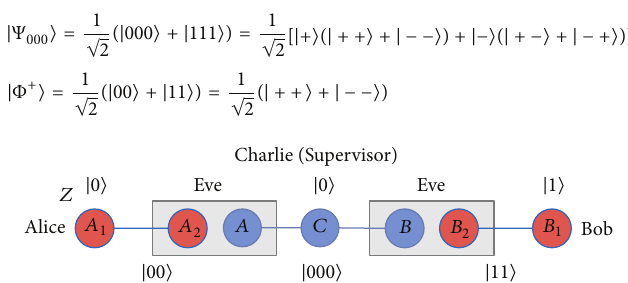
Figure 8: The scenario of external attack in which the legitimate users and controller measure the qubits 𝐴 1 , 𝐶 , and 𝐵 1 .